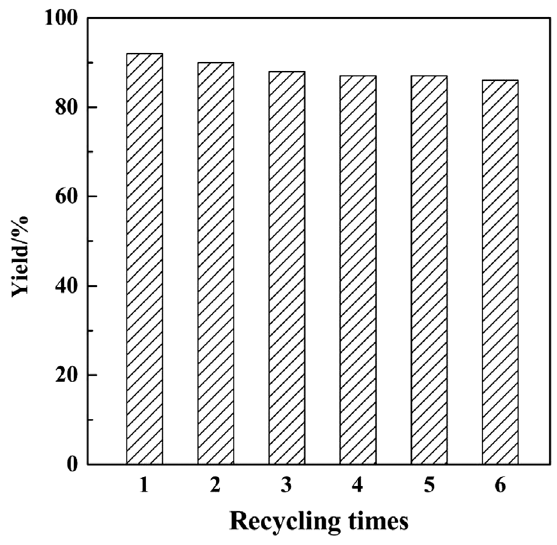
Figure 2: Reuse of ChCl/2PTSA for Biginelli